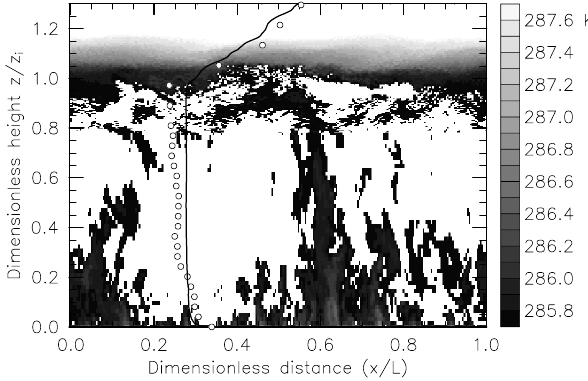
Fig. 2. Visualization of the structure of the boundary layer using potential temperature e 2 contours in a (x,z) plane located in the vicinity of an updraft at 15:00EST. The distances along x and z are scaled by the domain length L and the mixed layer depth z i , re- spectively. The grayscale color table indicates e 2 variations at the interface (lower and higher e 2 appear white). The e 2 profiles, mea- sured during the Wangara experiment ( ◦ ) and computed from the LES results as a horizontally-averaged profile over the computa- tional domain ( — ), are also included for